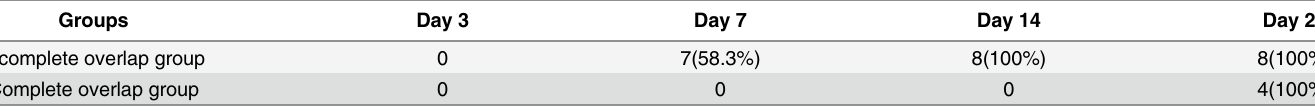
Table 2. Number (%) of sides showing PCO in the two groups.